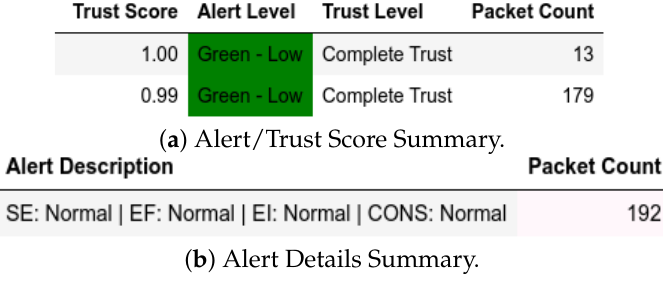
Figure 26. ATENA H2020 dataset internal test- H a in MitM capture-baseline replay.